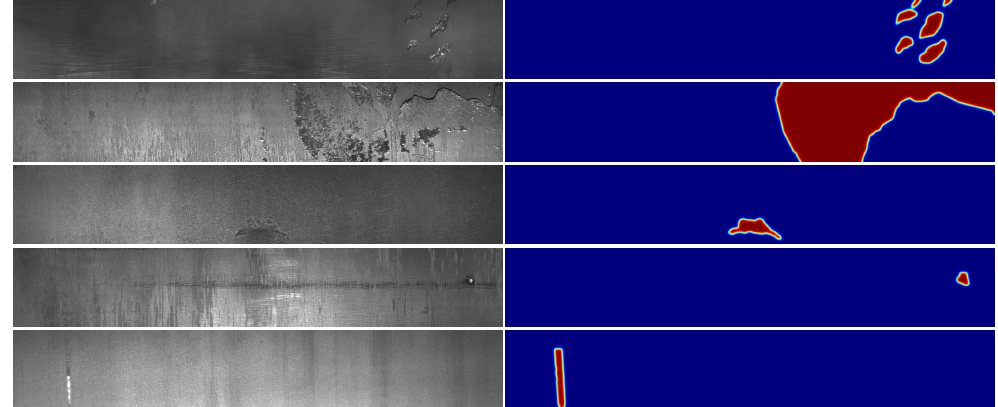
Figure 10. Severstal test examples semantic segmentation result of U-Net trained with the bal- anced loss.